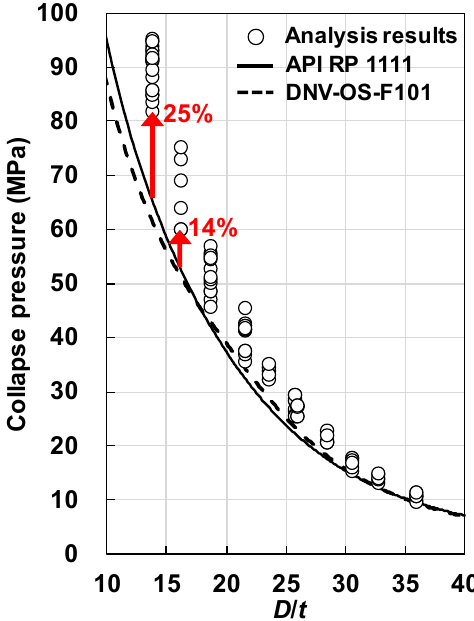
Figure 14. Comparison between analysis results and design standards.